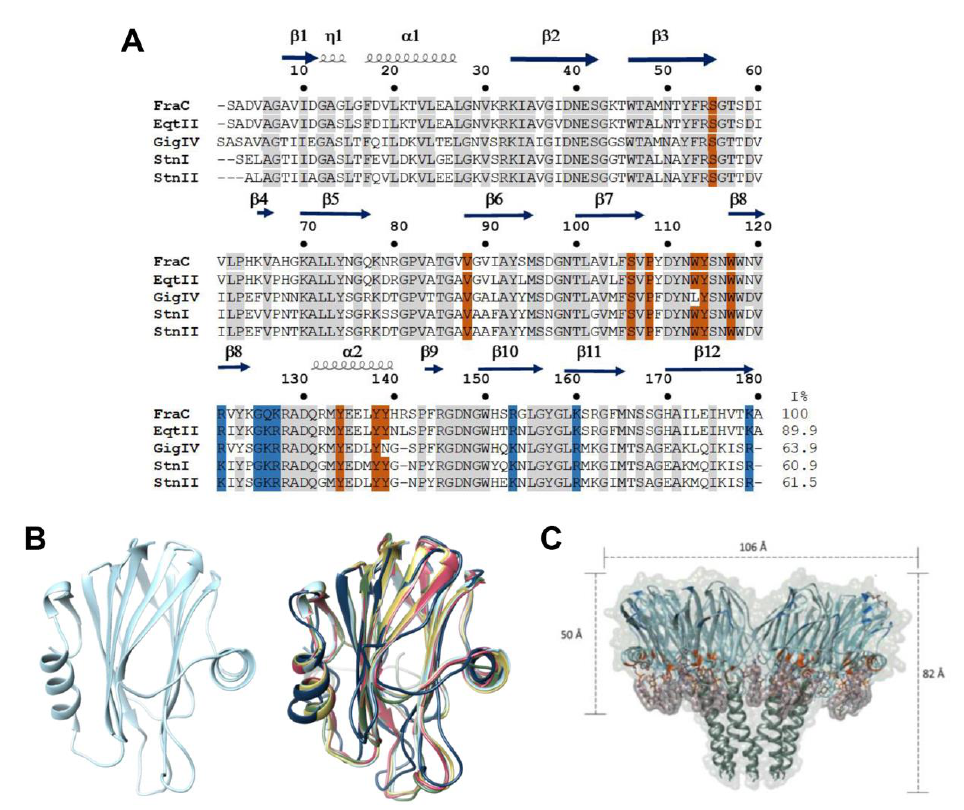
Figure 1. Structural characteristics of actinoporins. ( A ). Alignment of the most studied actinoporin sequences of the sea anemones Actinia fragacea (fragaceatoxin C, FraC), Actinia equina (equinatoxin II, EqtII), Stichodactyla helianthus (sticholysins I and II; StnI and StnII), Stichodactyla gigantea (gigantoxin-4, GigIV). The residues that interact with phosphocholine (POC) are highlighted in orange, the residues that interact with the membrane are in blue, and conserved residues are indicated in gray. ( B ). Structural alignment of actinoporins. All the Root mean square distances (RMSDs) were calculated using the structure of FraC as the reference structure, FraC (PDB 3VWI) in light blue, Stn I with a RMSD 1.208 Å (PDB 2KS4) in navy blue, Stn II with a RMSD 0.483 Å (PDB 1GWY) in pink, Eqt II with a RMSD 0.401 Å (PDB 1KD6) in yellow, GigIV with a RMSD 0.422 Å (I-TASSER model) in green [78]. ( C ). FraC oligomer (PDB 4TSY). FraC is shown in light blue, the residues that interact with POC are colorized in orange, and the residues that interact with the membrane are in blue. The zone in direct contact with the ligands is in purple, whilst the membrane is in green. The distances were obtained with the program UCSF Chimera ® [79].